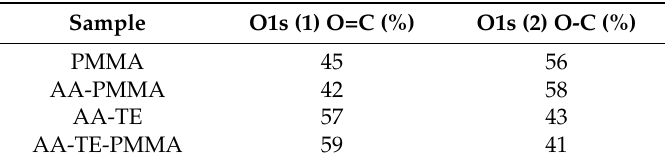
Table 1. O1s peak area of oxygen plasma-treated PMMA.